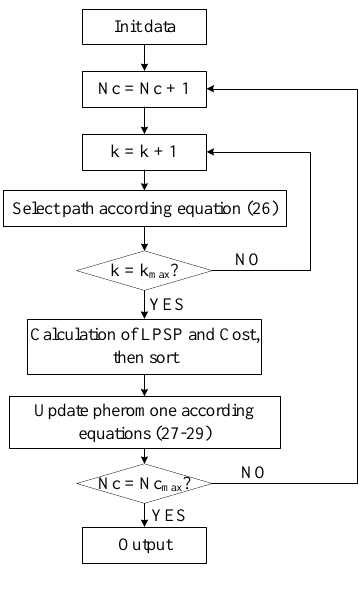
Figure 7. Algorithm